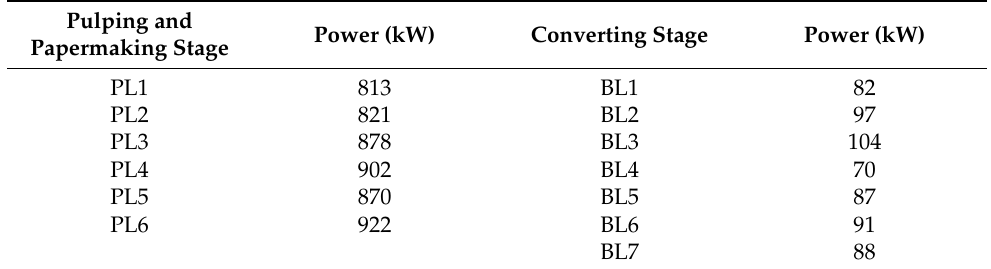
Table 5. The setup power of the production line in the pulping and papermaking stage and the converting stage.